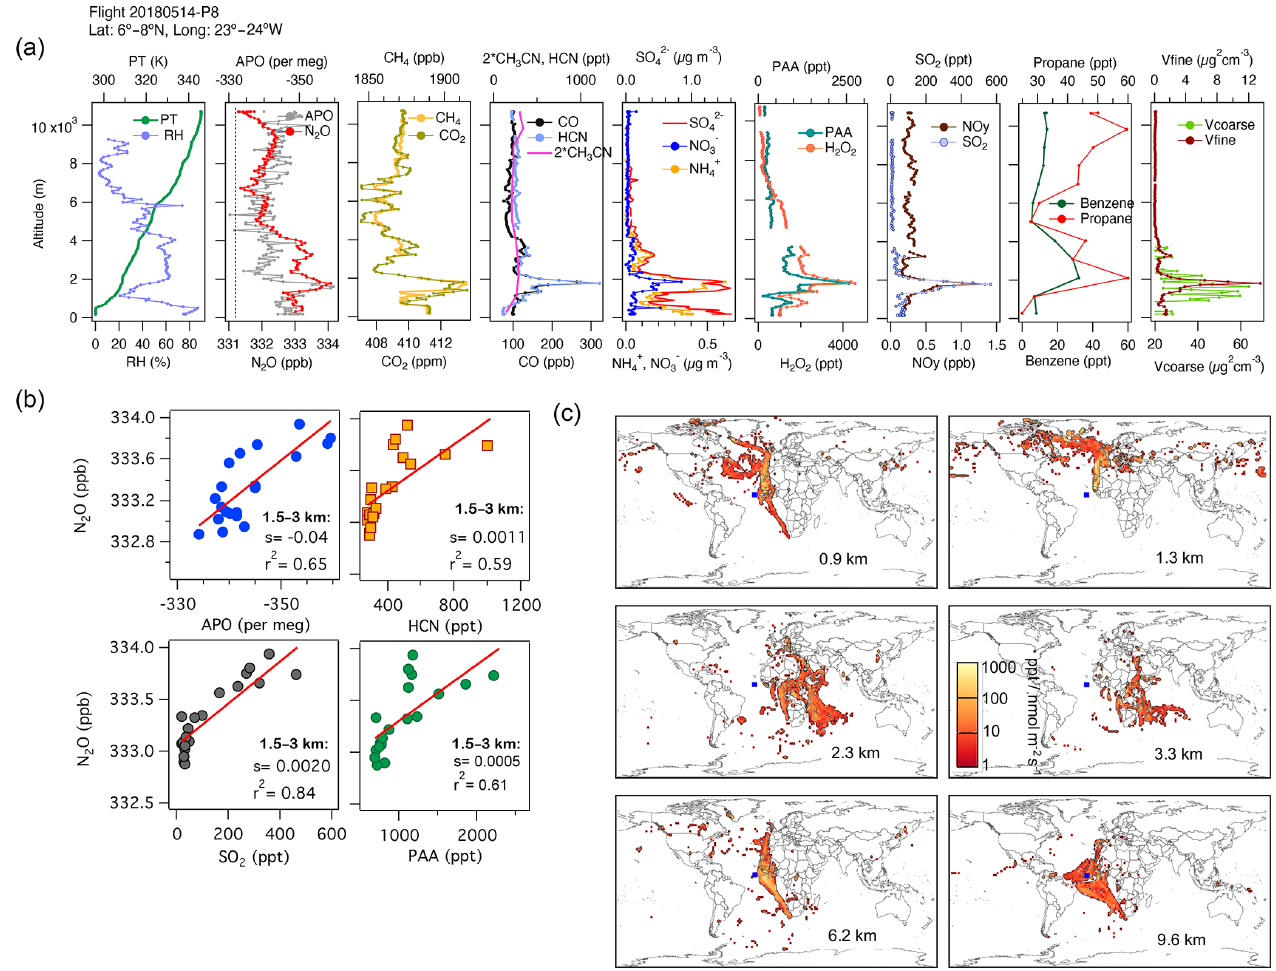
Figure 7. (a) Vertical profiles of PT, RH, the tracers N 2 O, APO, CH 4 , CO 2 , CO, HCN, CH 3 CN, NO − NO y , benzene, and propane, and the volumes of coarse and fine particles from profile 8 on 14 May 2018. The dotted blue line in the plot of APO and N 2 O represents the NOAA-MBL reference (N 2 O-MBL) at the latitude of the flight. (b) Correlations between N 2 O and APO, HCN, SO 2 , and propane at altitudes of 1–3km show possible contributions from marine upwelling, biomass burning, and the oil and gas industry, as supported by the footprints ( s represents the slope of the linear fit). (c) Footprint maps tracing surface regions that influence mixing ratios measured in the altitude ranges 0–1, 2–4, 4–5, 5–7, and 7–10km, respectively. The blue square shows the sampling location. Values below 3pptnmol − 1 m 2 s are not included. Note that the APO axes are